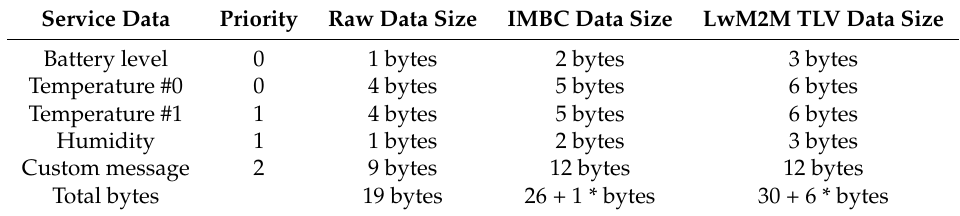
Table 4. Service data priority and the payload size of the raw data, the IMBC data and the LwM2M TLV